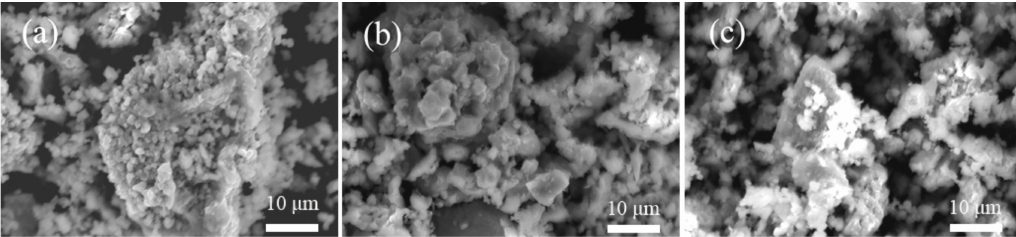
Figure 2. SEM images of Li[Li 0.2 Mn 0.56 Ni 0.16 Co 0.08 ]O 2 prepared at di ff erent temperature of ( a ) 800 ◦ C, ( b ) 900 ◦ C, ( c ) 1000 ◦ C.